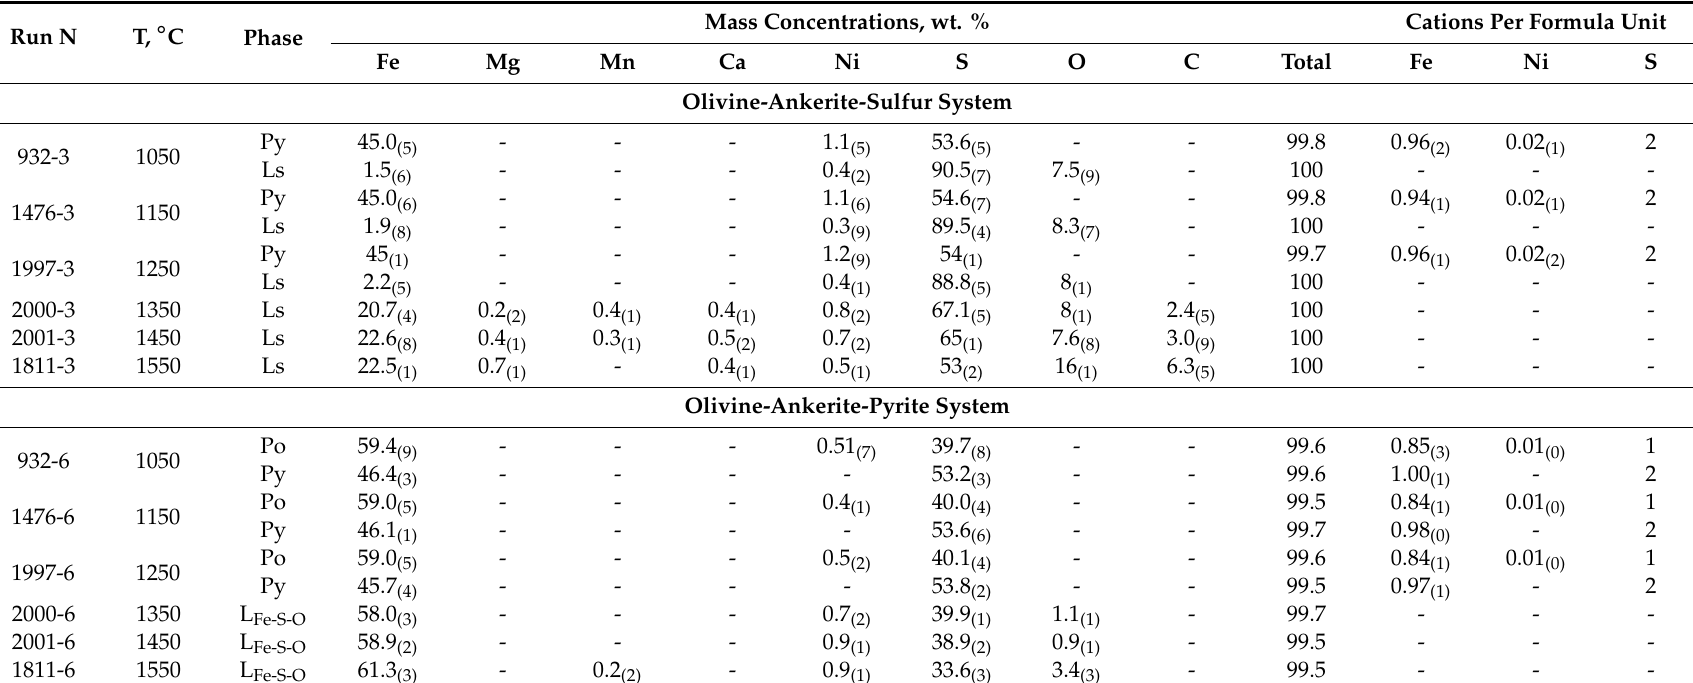
Table 5. Averaged compositions of sulfides, as well as predominantly sulfur and sulfide